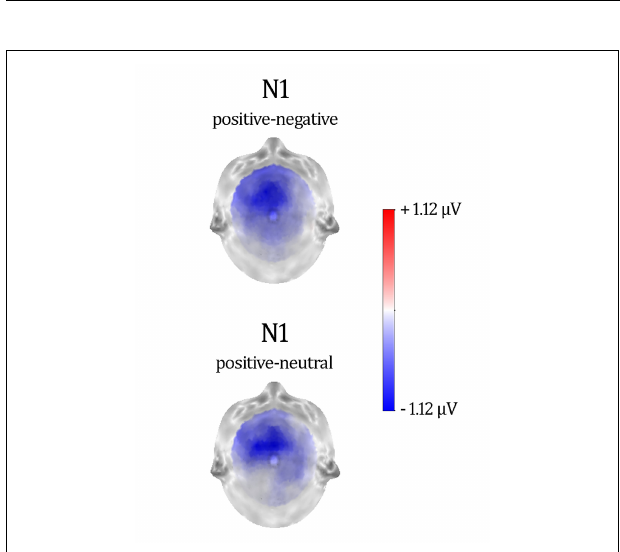
FIGURE 3 | Difference maps showing distractor type effects in N1. These maps were computed at the peak latency of N1.